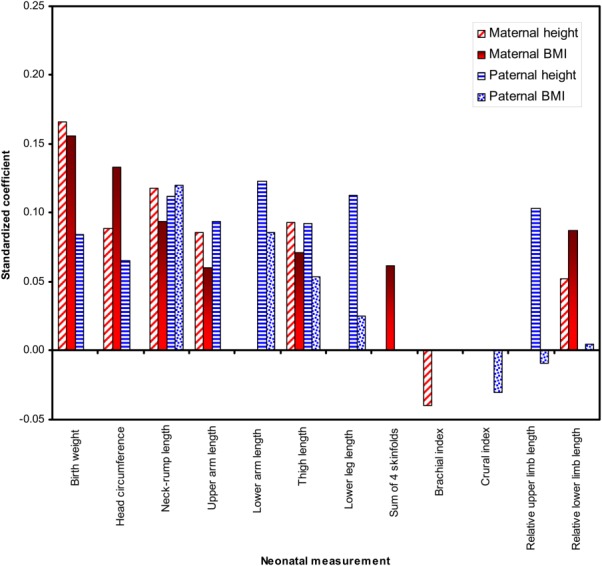
Standardized coefficients (β) for variation in neonatal anthropometry explained by parental anthropometry. [Color figure can be viewed in the online issue, which is available at wileyonlinelibrary.com.]